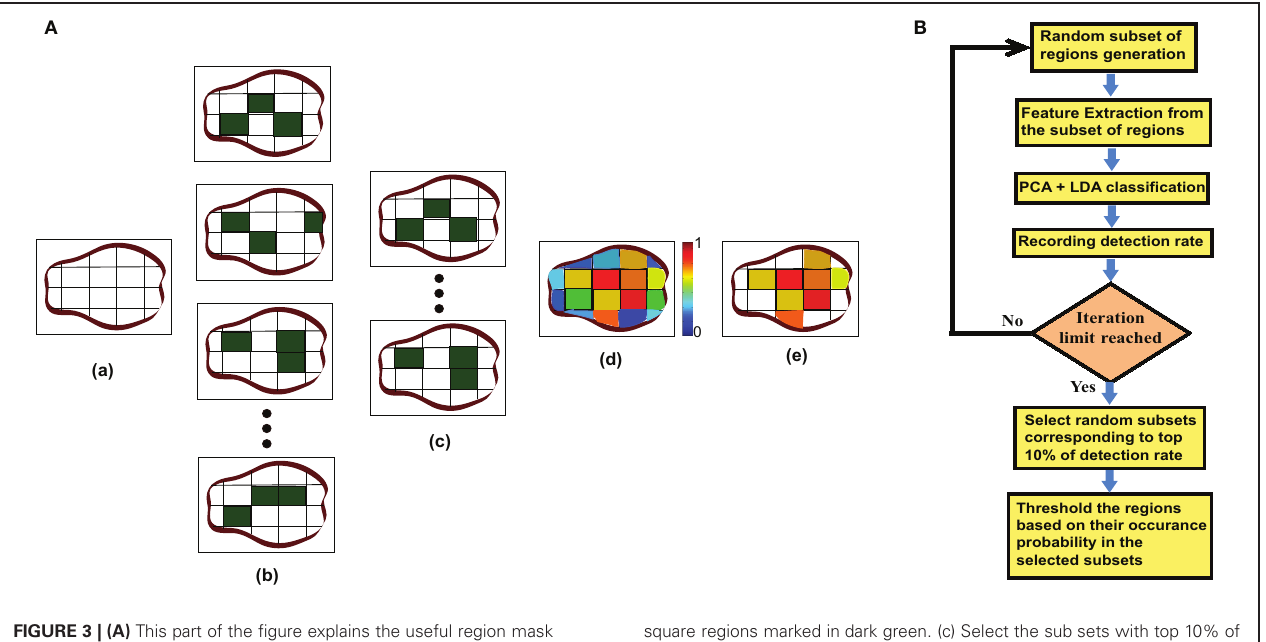
FIGURE 3 | (A) This part of the figure explains the useful region mask generation algorithm on a single brain slice. The figure is just a graphical example, not the real data. In actual experiments brain volumes are used instead of slices and cube regions are used instead of square subdivision areas. (a) Divide the slice into square regions. (b) Select random sub sets of